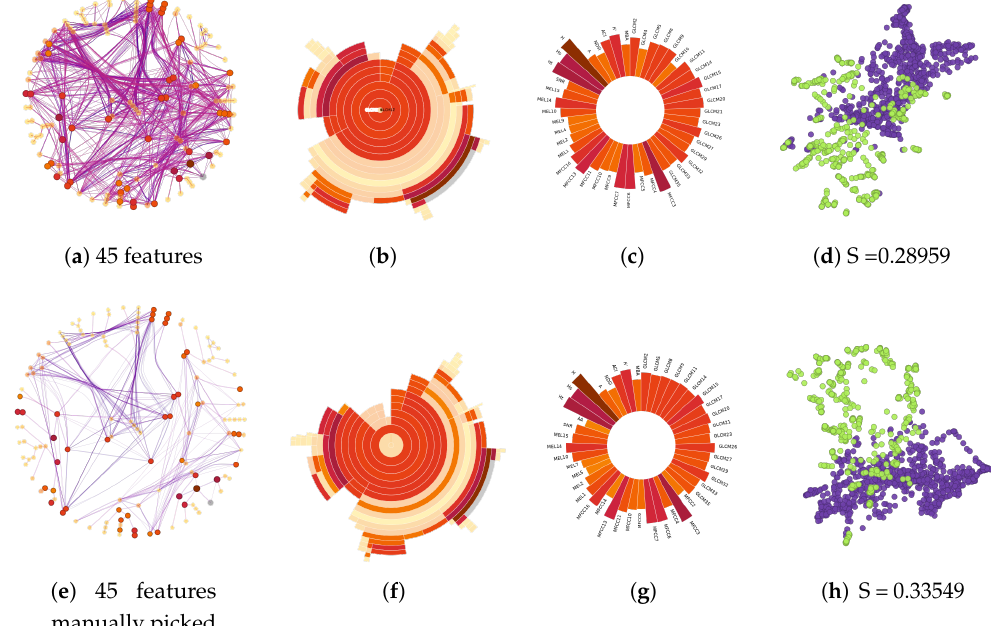
Figure 7. Soundscape ecology data with 141 features from bird and insect classes. ( a ) MST with additional graph edges highlighting 45 features selected automatically by ranked relevance and ( b ) Sunburst visualization of the features. ( c ) Circular histogram of the selected features. ( d ) The LSP projection of the 1662 data points from the space of selected features on 2D and its silhouette coefficient. ( e – h ) The same types of layouts for 45 features selected by a combination of calculated rank and